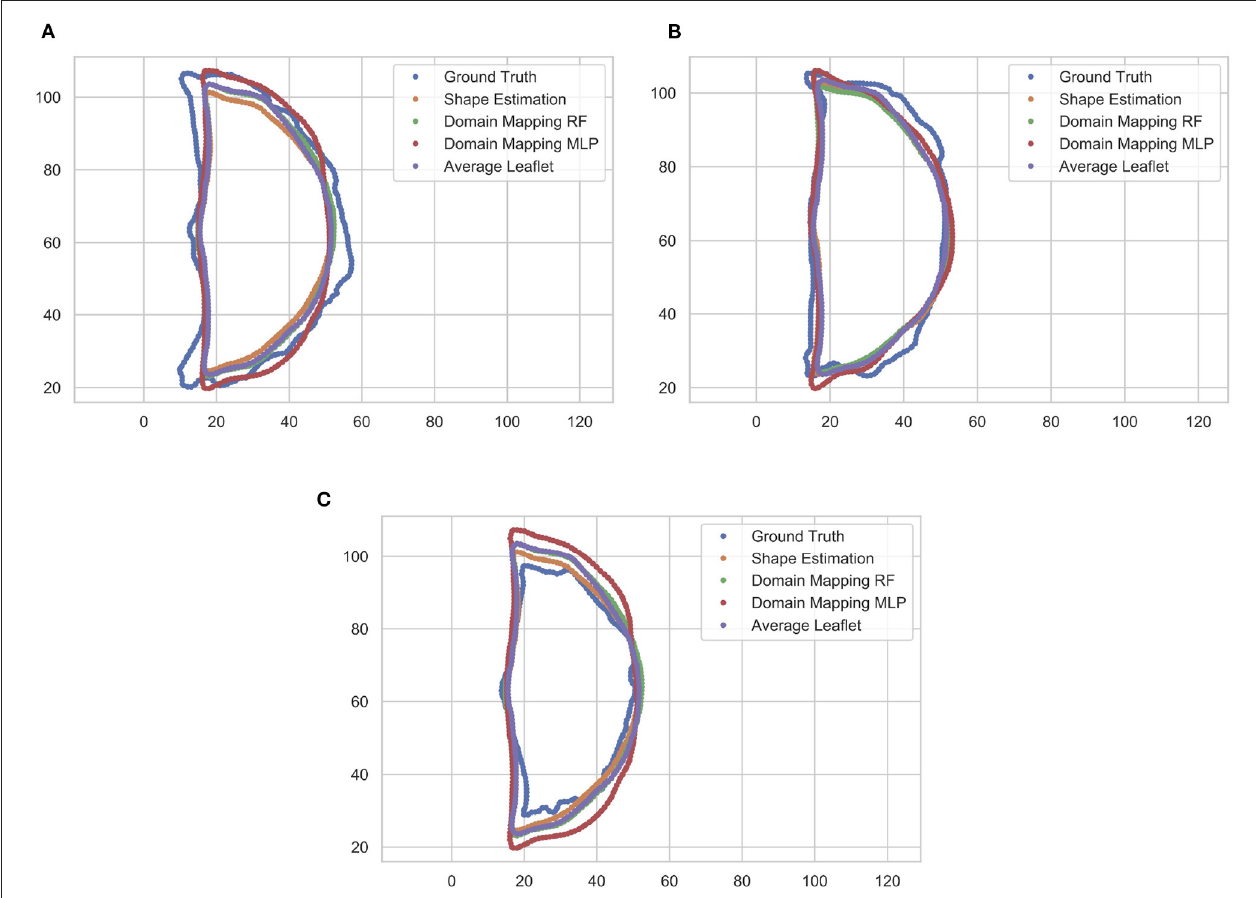
FIGURE 10 | Comparison of predicted leaflet contour lines for the different prediction models as well as the ground truth, exemplarily shown for three typical cases. Typically, the domain mapping approach with MLP shows the best approximation (A) . For leaflets that are close to the average shape, all models provide a satisfying prediction (B) . If the leaflet is small, all prediction models tend to overestimate the size of the leaflet (C) . The contour lines are given in pixel